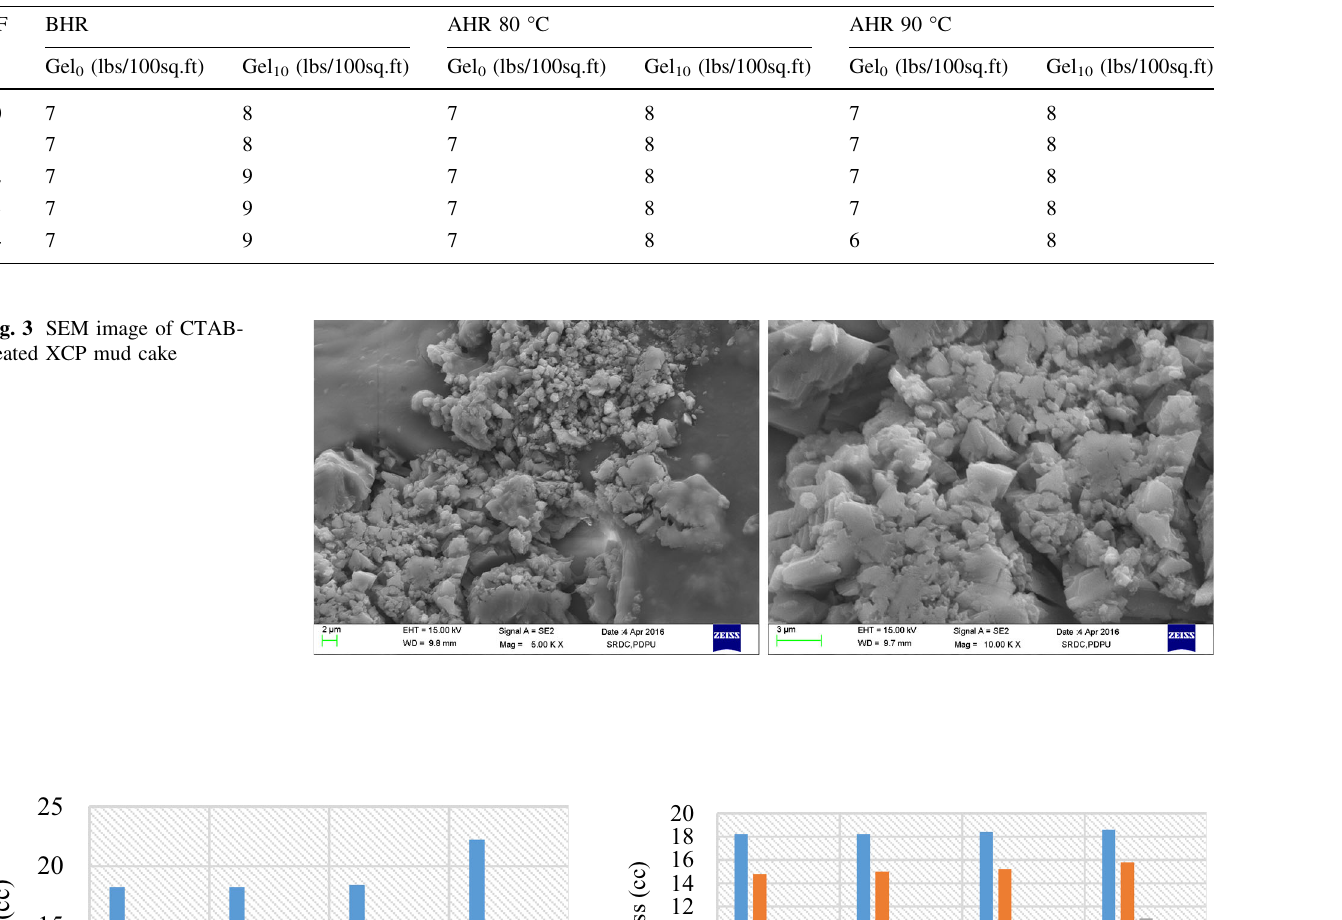
Table 10 Mud rheology of CTAB in combination with PGS in K 2 SO 4 -inhibited mud system